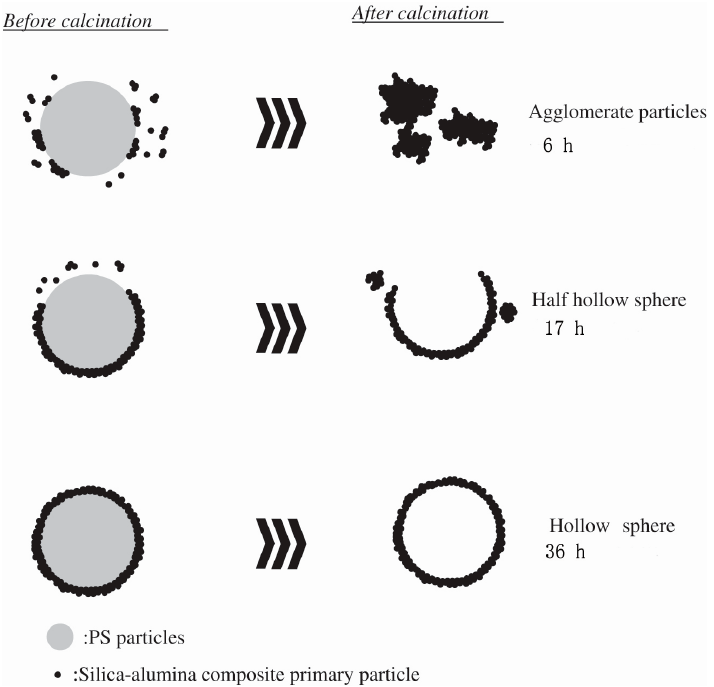
Figure 6. Schematic illustration of formation process of the hollow spheres with different coating time (6, 17, 36 h) [72]. (6, 17, 36 h)